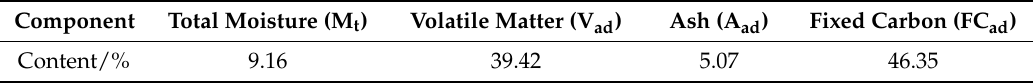
Table 2. Proximate analysis of the coal used. Table 3. Chemical composition of coal ash.